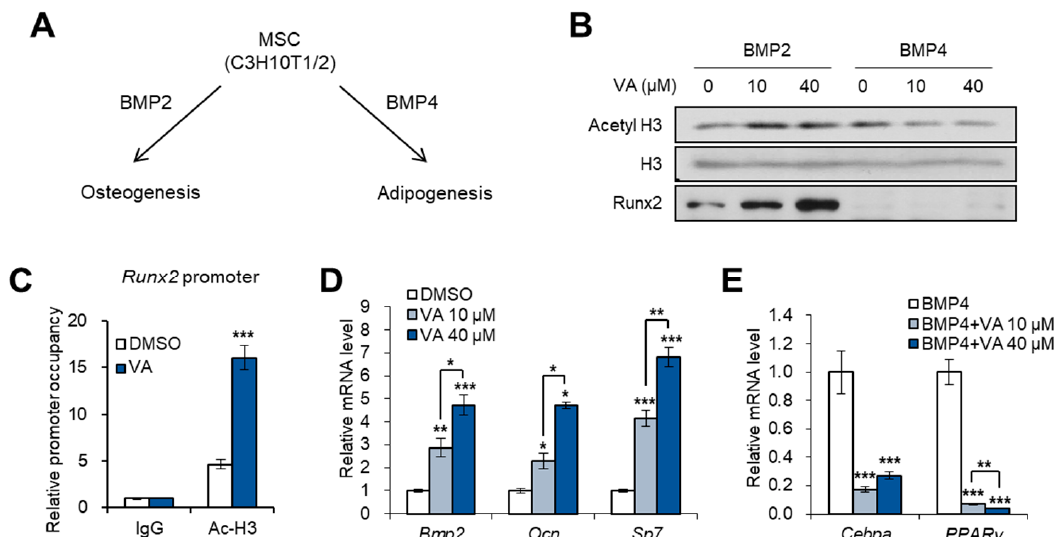
Figure 3. Vulpinic acid induces osteogenesis via H3 acetylation in 10T1 / 2 MSCs. ( A ) Schematic representation of BMPs-mediated osteogenic or adipogenic commitment of MSCs. ( B ) Immunoblot analysis of 10T1 / 2 cells treated with vulpinic acid (10 or 40 µ M) for 24 h in the presence of BMP2 or BMP4. ( C ) 10T1 / 2 cells were treated with or without vulpinic acid (40 µ M) for 24 h in the presence of BMP2 or BMP4. ChIP assay was performed with IgG and acetylated H3 antibodies followed by real time PCR with primers for promoter region of Runx2 gene. ( D ) The mRNA levels of the Bmp2 , Ocn , and Sp7 genes in 10T1 / 2 cells treated with vulpinic acid (10 or 40 µ M) for 24 h. ( E ) The mRNA levels of Cebpa and PPAR γ genes in 10T1 / 2 cells treated with vulpinic acid (10 or 40 µ M) for 24 h in the presence of BMP4. Data represent means ± SEM for n = 3. * p < 0.05, ** p < 0.01, *** p < 0.001.